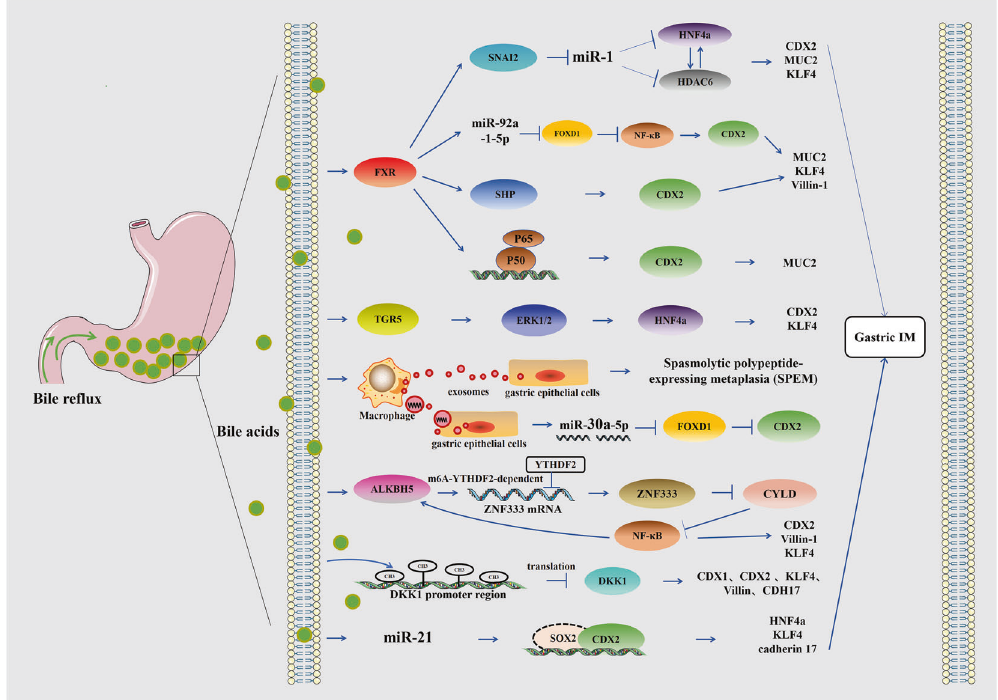
Fig. 3 Mechanism of bile acid-induced gastric IM. Bile acids increase intestinal marker expression via the pathways of FXR/SNAI2/miR-1, FXR/ miR-92a-1 – 5p/FOXD1/NF- κ B/CDX2, FXR/SHP/CDX2, FXR/NF- κ B/CDX2, TGR5/ERK1/2/HNF4a, miR-21/SOX2/CDX2, and the promoter methyla- tion and downregulation of DKK1 in the stomach. An m6A modi fi cation-associated positive feedforward loop between ALKBH5 and NF-kB signaling is involved in generating the IM. Bile acid-induced ALKBH5 enhances ZNF333 levels through an m6A – YTHDF2-dependent manner. In addition, macrophage-derived exosomes facilitate cellular communication between macrophages and gastric epithelial cells in the DCA microenvironment, which promotes the development of SPEM and contributes to gastric IM by transferring